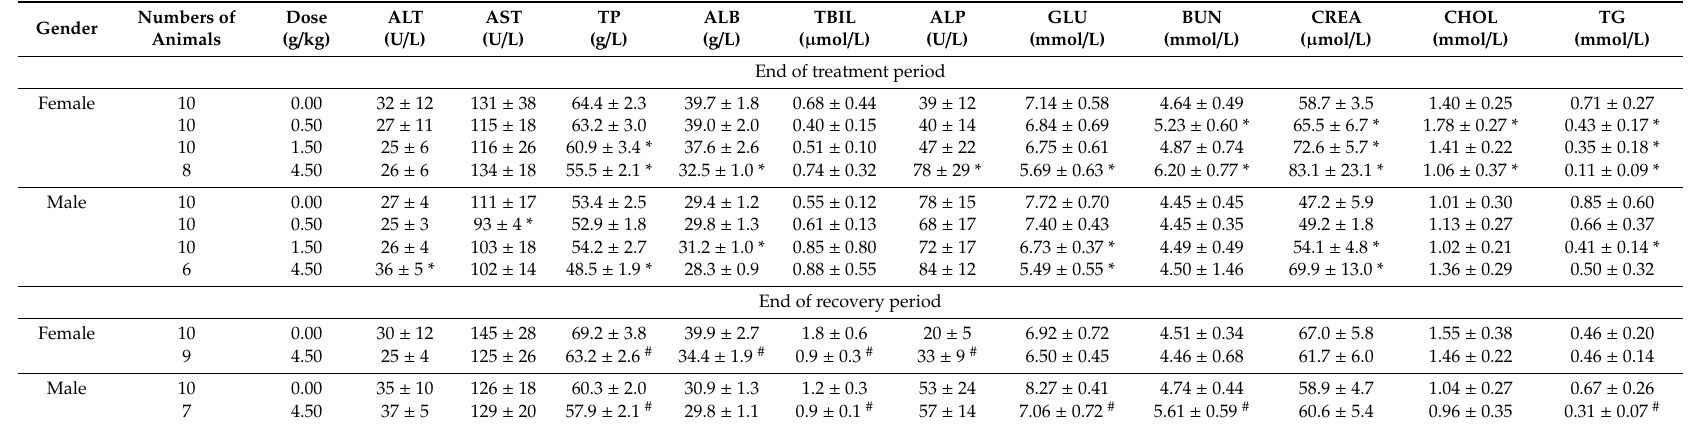
Table 2. Clinical biochemistry parameters of S-D rats orally administrated with gardenia yellow for 90